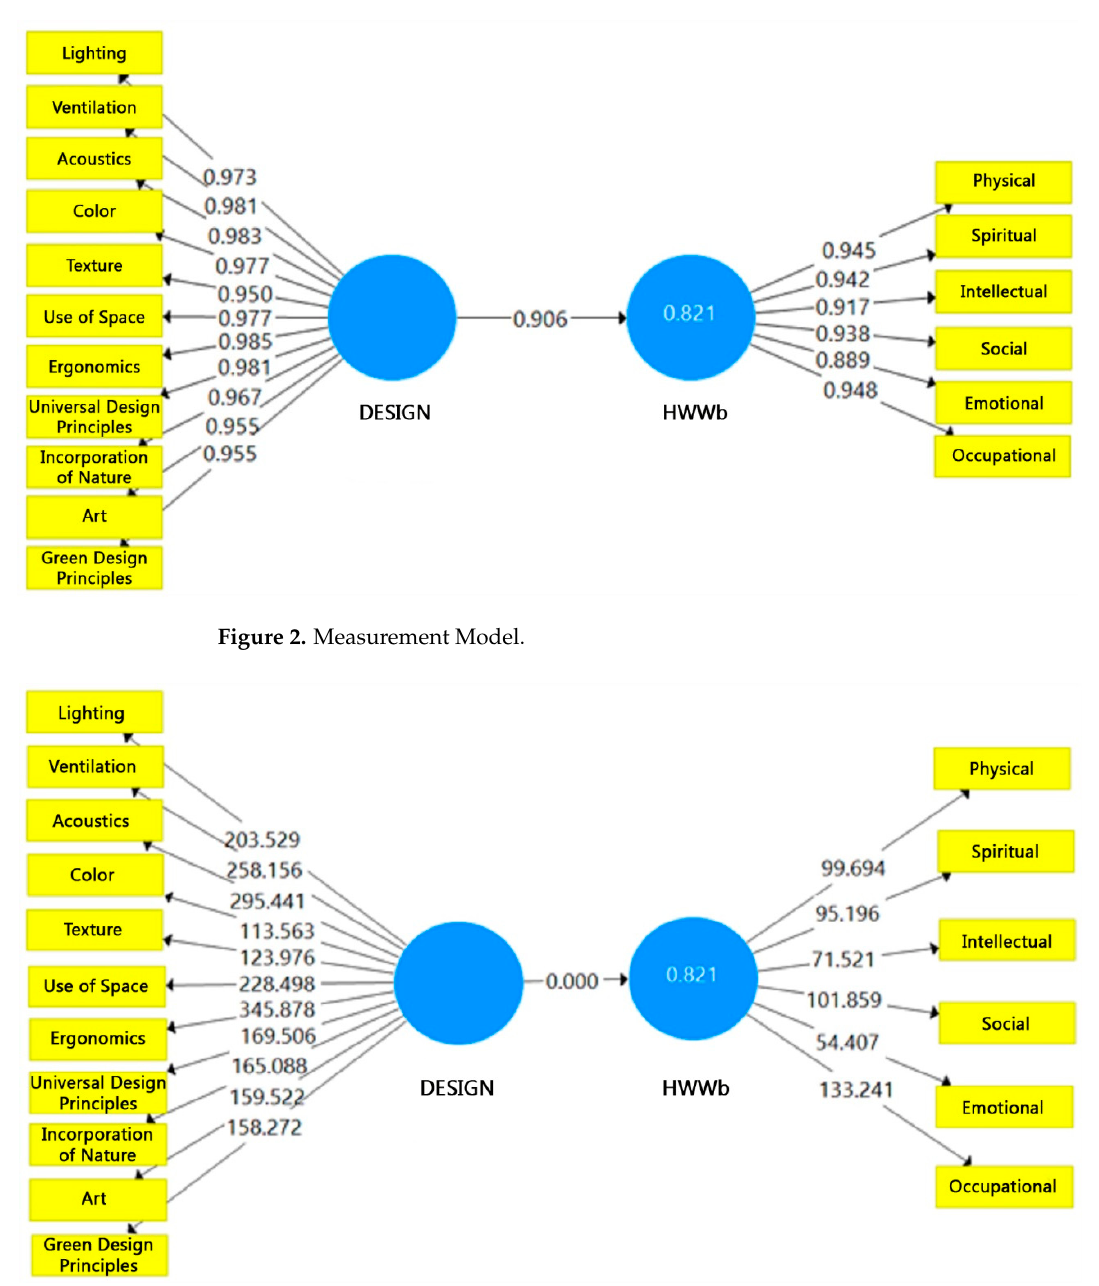
Figure 3. Structural Model.